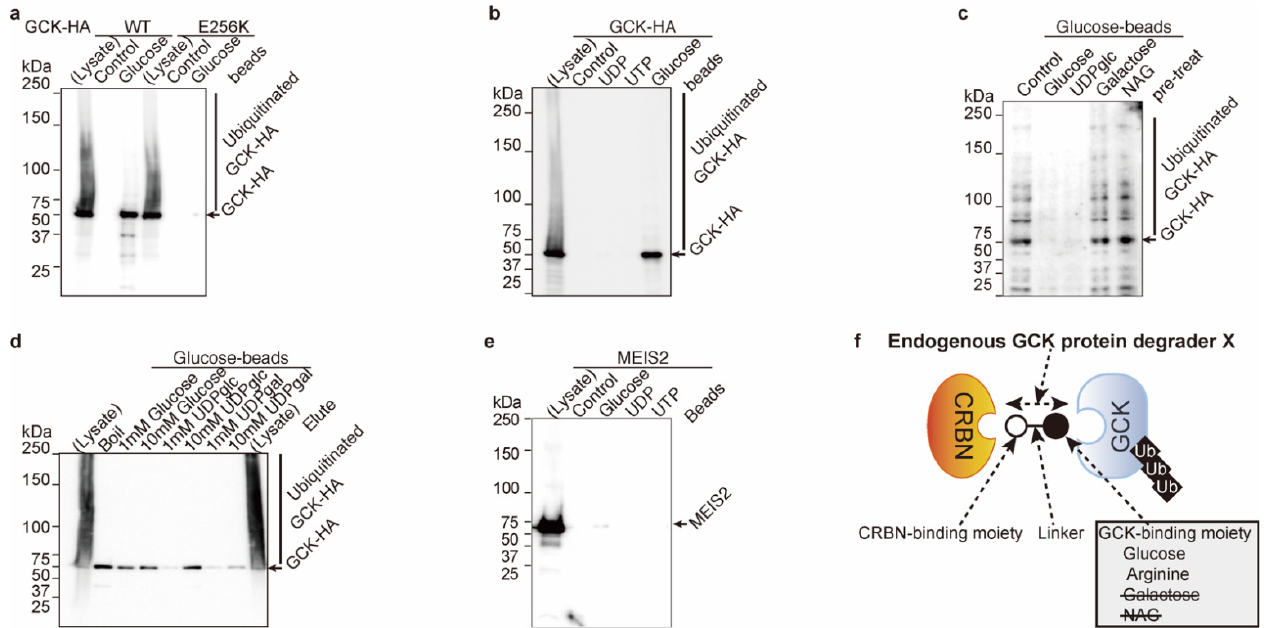
Figure 1. Glucose inhibits glucokinase (GCK) ubiquitination and degradation. ( a ) The E256 residue of glucokinase is involved in glucose binding. Glucokinase WT and glucokinase E256K proteins were mixed with control or glucose-immobilized beads, and the binding fraction was eluted by boiling. Glucokinase proteins were detected by WB. ( b ) Glucokinase does bind to glucose but does not bind to UDP or UTP. Glucokinase protein was mixed with control-, UDP-, UTP- or glucose-immobilized beads, and bead-binding glucokinase protein was dissociated by boiling from beads. Beads binding glucokinase were detected by WB. ( c ) Glucokinase binds to glucose and UDP-glucose and does not bind to galactose and N-acetyl glucosamine (NAG). Glucokinase proteins were pretreated with control, glucose, UDP-glucose, galactose or N-acetyl glucosamine (NAG) and then mixed with glucose beads. Beads binding glucokinase was eluted by boiling. Glucose beads binding glucokinase were detected by WB. ( d ) Glucokinase binds to glucose, and UDP-glucose does not bind to UDP-galactose. Glucose beads binding glucokinase proteins were eluted by glucose, UDP-glucose, or UDP-galactose. Eluted glucokinase was detected in glucose and UDP-glucose elution but not in UDP-galactose elution. ( e ) Cereblon (CRBN) substrate protein MEIS2 has no binding activity to glucose, UDP, and UTP. MEIS2 protein was mixed with control, glucose, UTP, and UDP-immobilized beads, and the beads were washed and boiled. Bead-bound MEIS2 was detected by WB. ( f ) Graphic summary Glucokinase-binding moiety of endogenous glucokinase protein X was glucose and